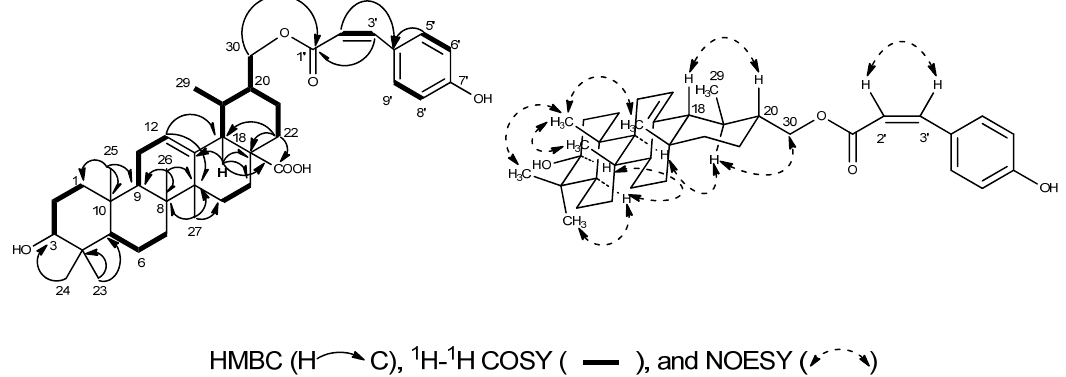
Figure 2. 1 H- 1 H COSY, Key HMBC, and NOESY correlations of compound 1